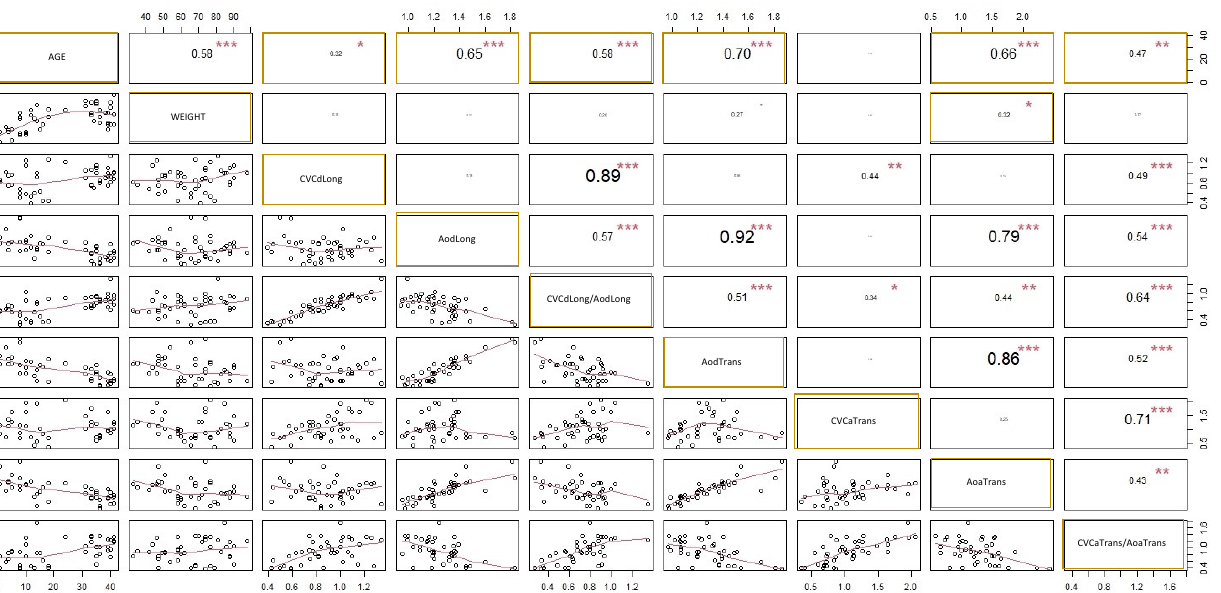
Figure 5. Correlation coefficients (R 2 ) between calves’ age and weight and caudal vena cava (CVC) and aorta (Ao) measurements at paralumbar views (PV). ***: p < 0.001, **: p < 0.01, *: p < 0.05. CVCdLong and AodLong are respectively CVC and Ao diameter at longitudinal PV, and CVCdLong and AodLong are the CVC and Ao diameter index in longitudinal PV. AodTrans is Ao diameter in transversal PV, CVCaTrans and AoaTrans are respectively CVC and Ao area at transversal PV, and CVCaTrans and AoaTrans are the CVC and Ao area index in transversal PV.